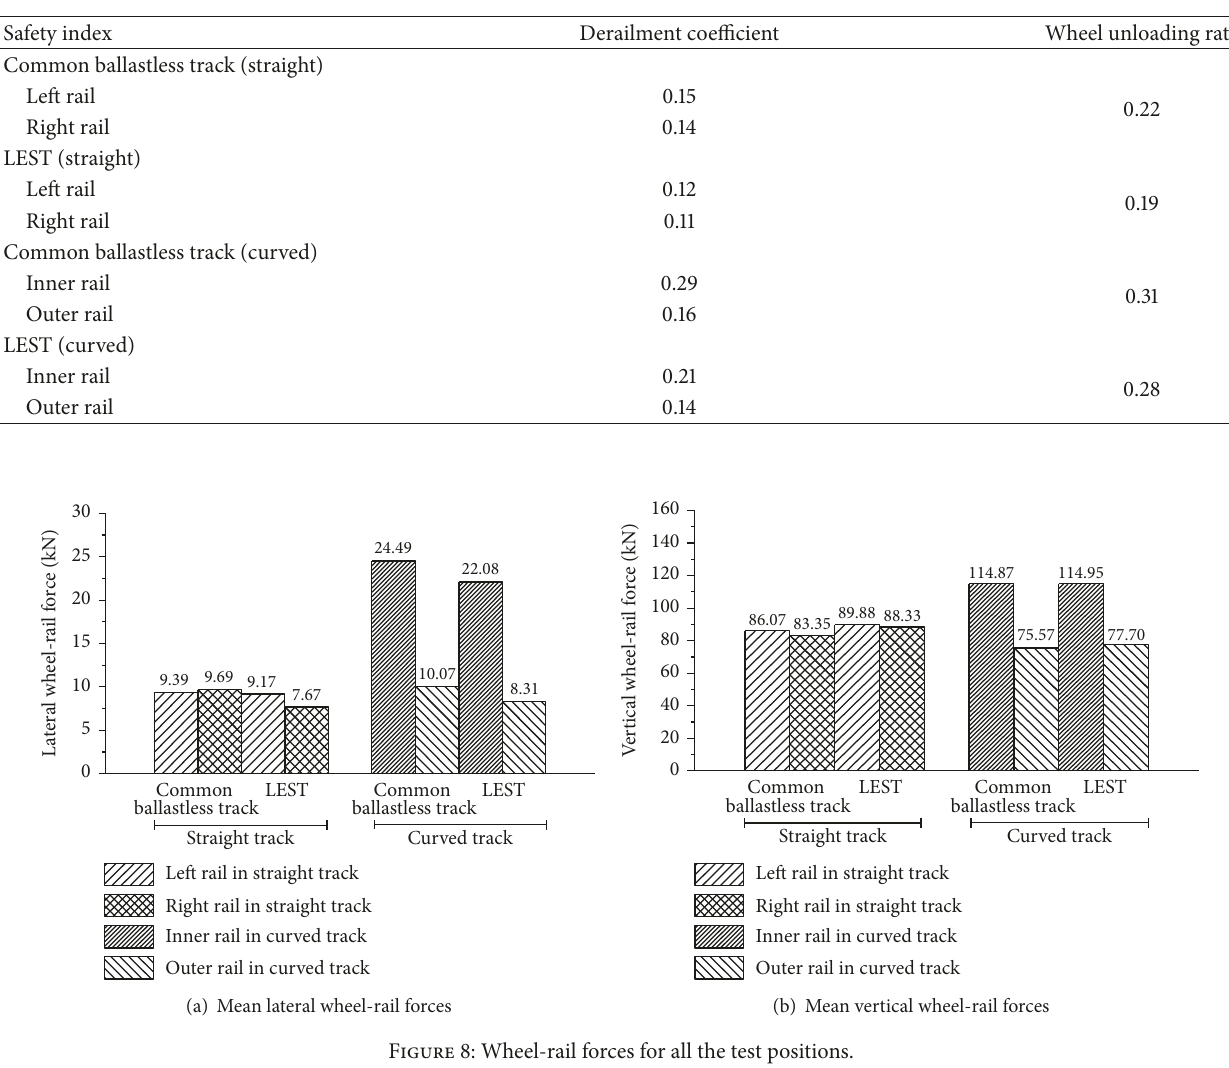
Table 2: Statistics of train safety indices.